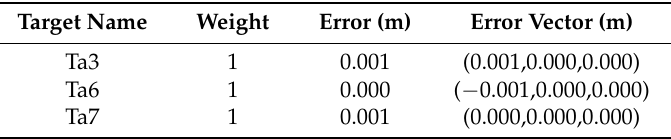
Table 4. Automatic registration error by Leica Cyclone software.